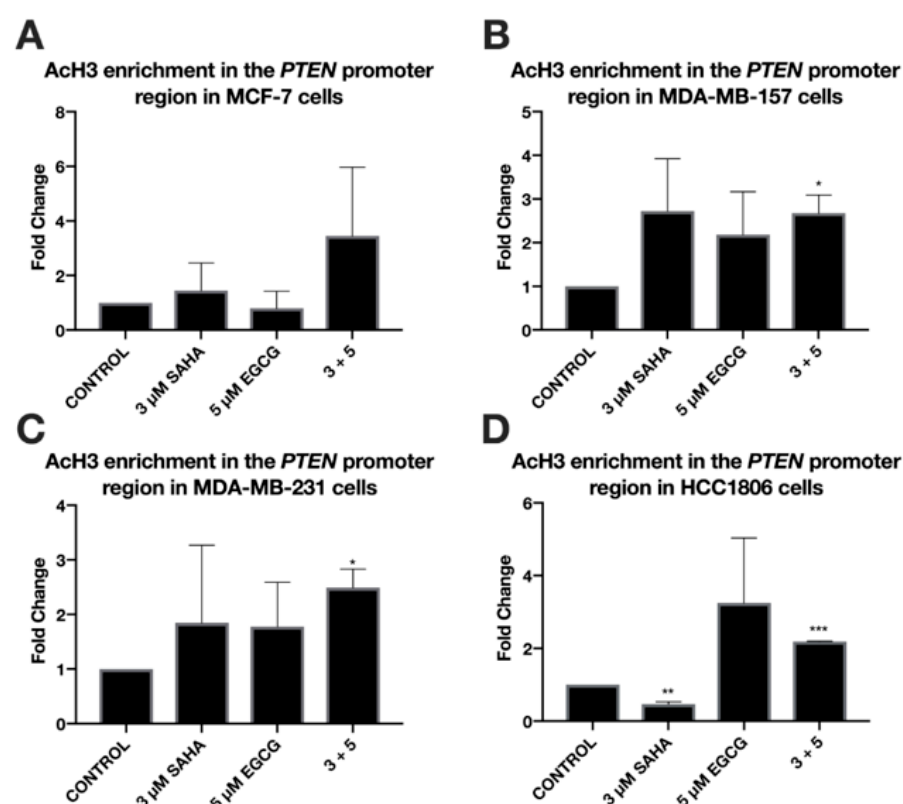
Figure 11. Enrichment of acetylated histone H3 within the PTEN promoter is associated with the treatment of SAHA and EGCG in three TNBC cell lines. ( A ) ChIP qRT-PCR was performed in MCF-7 breast cancer cells utilizing an AcH3 antibody (Millipore Sigma) and an H3 antibody (Abcam) for a positive control. Primers for a region of the PTEN promoter were used (Integrated DNA Technologies) in conjunction with the ChIP kit (Abcam). Cells were treated for 3 days with the indicated compounds prior to performing ChIP ( n = 3). ( B – D ) The same was done in MDA-MB-157, MDA-MB-231, and HCC1806 TNBC cell lines ( n = 3). * p < 0.05; ** p < 0.01; *** p <